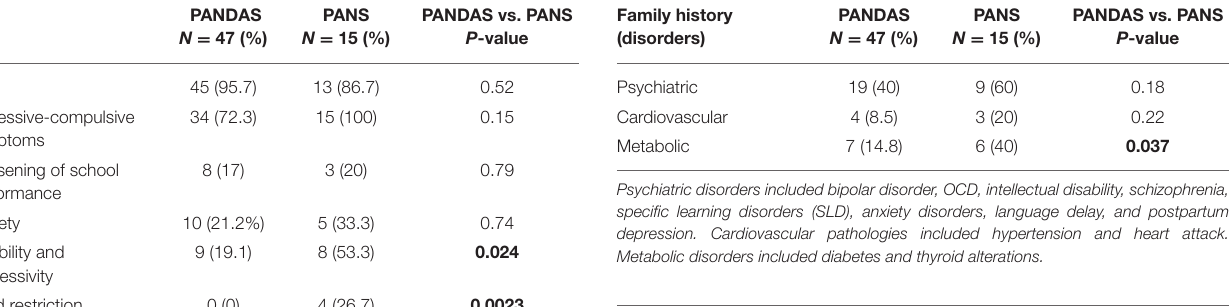
TABLE 5 | Therapy in PANDAS-PANS